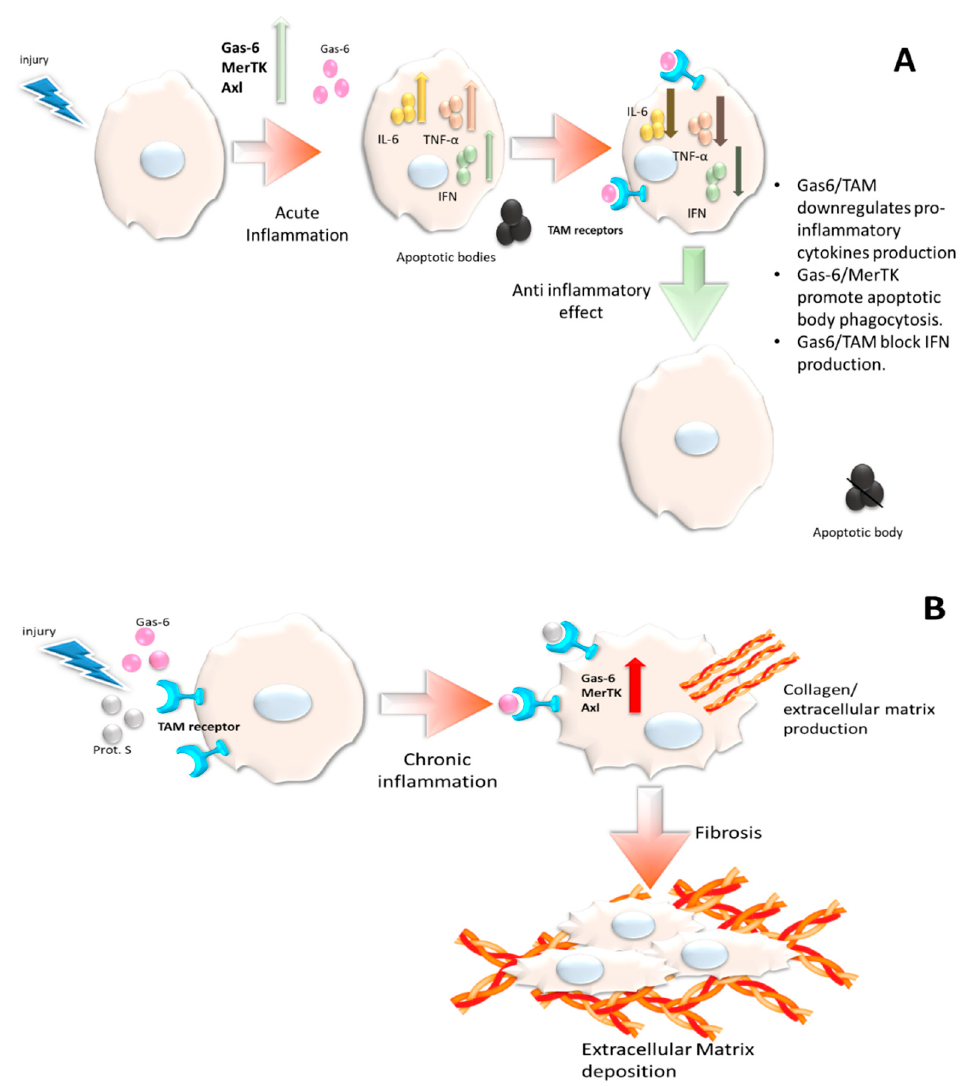
Figure 1. A potential model of Gas6/TAM activity in the case of acute and chronic injury. ( A ) A cell exposed to a damage overexpressing Gas6/TAM receptors. The arrow pointing upward means increasing. Down arrow means decreasing. The system exerts its anti-inflammatory activities: efferocytosis, switch-off of IFN signature, and downregulation of inflammatory cytokines expression. This contributes to self-limitation of inflammatory response. ( B ) The overexpression of Gas6/TAM receptors induced by chronic exposition to a stressor, leading to the production and release of extracellular matrix, ultimately contributing to fibrosis development.